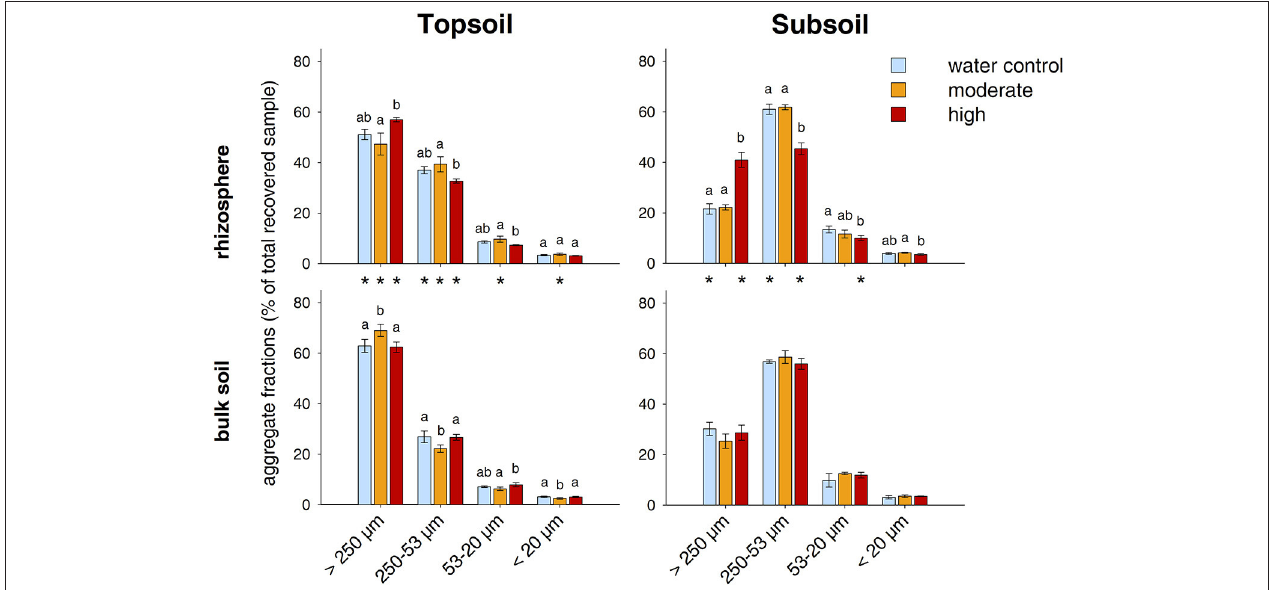
FIGURE 5 | Distribution of water-stable aggregate size classes. Bars represent standard deviation from the mean (SD). Different letters indicate statistically significant differences between the treatments within one soil region and depth ( p < 0.05), asterisks indicate statistically significant differences between the soil regions rhizosphere and bulk soil within one soil depth and